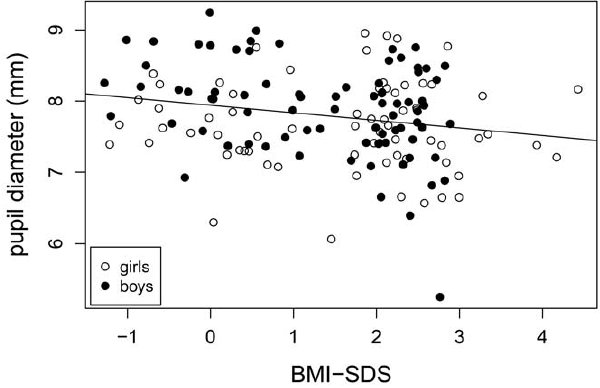
Figure 3. Correlation between pupil diameter (index of sympathetic nervous system) and BMI-SDS in 149 normal- weight and obese children. Pearson’s correlation coeffi- cient= 2 0.21, 95% CI=[ 2 0.36, 2 0.05], (p=0.01).